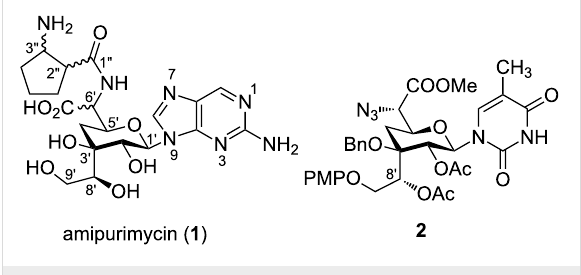
Figure 1: Antifungal antibiotic amipurimycin ( 1